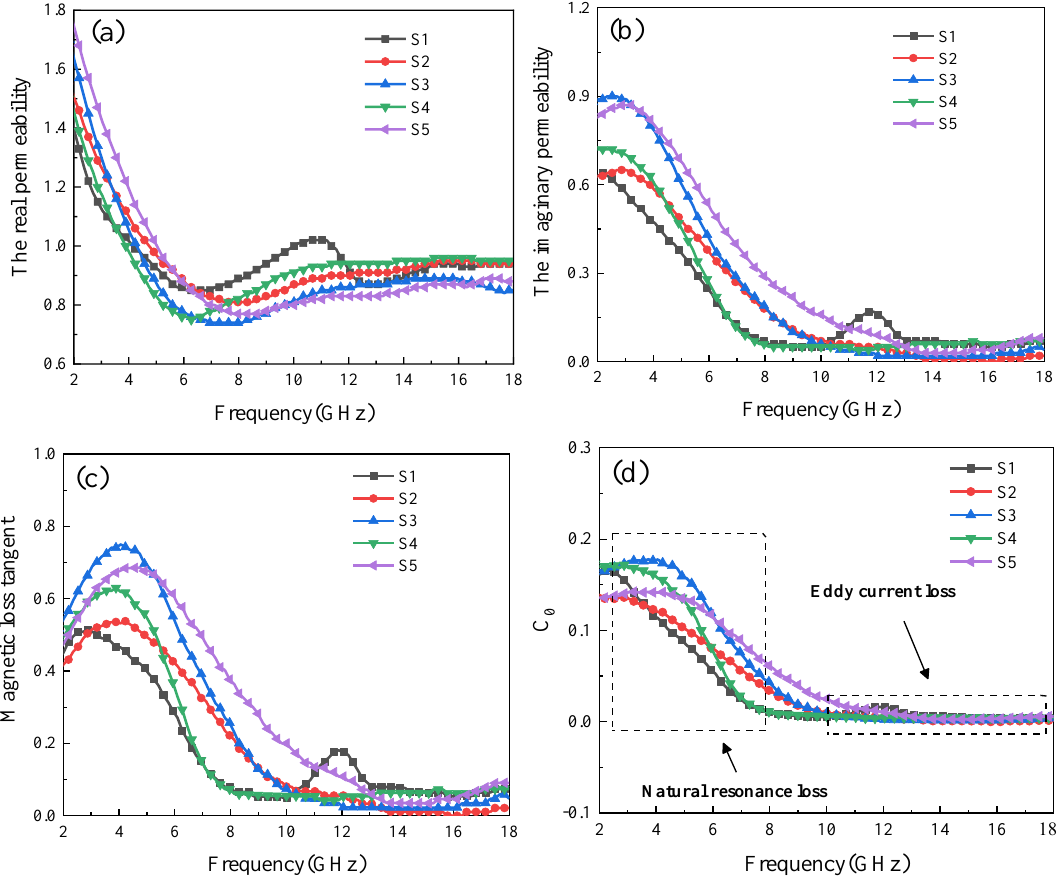
Figure 5. ( a ) The real part of permeability, ( b ) the imaginary part of permeability, ( c ) magnetic loss tangent, and ( d ) C 0 curves in the range of 2–18 GHz.